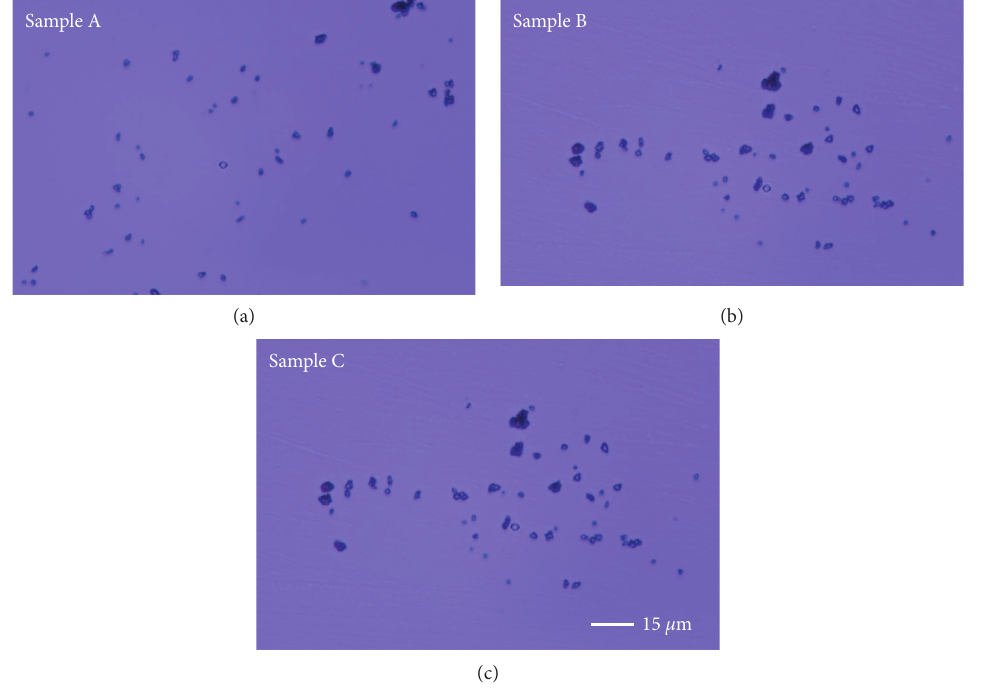
Figure 7: Micrographs of three groups of